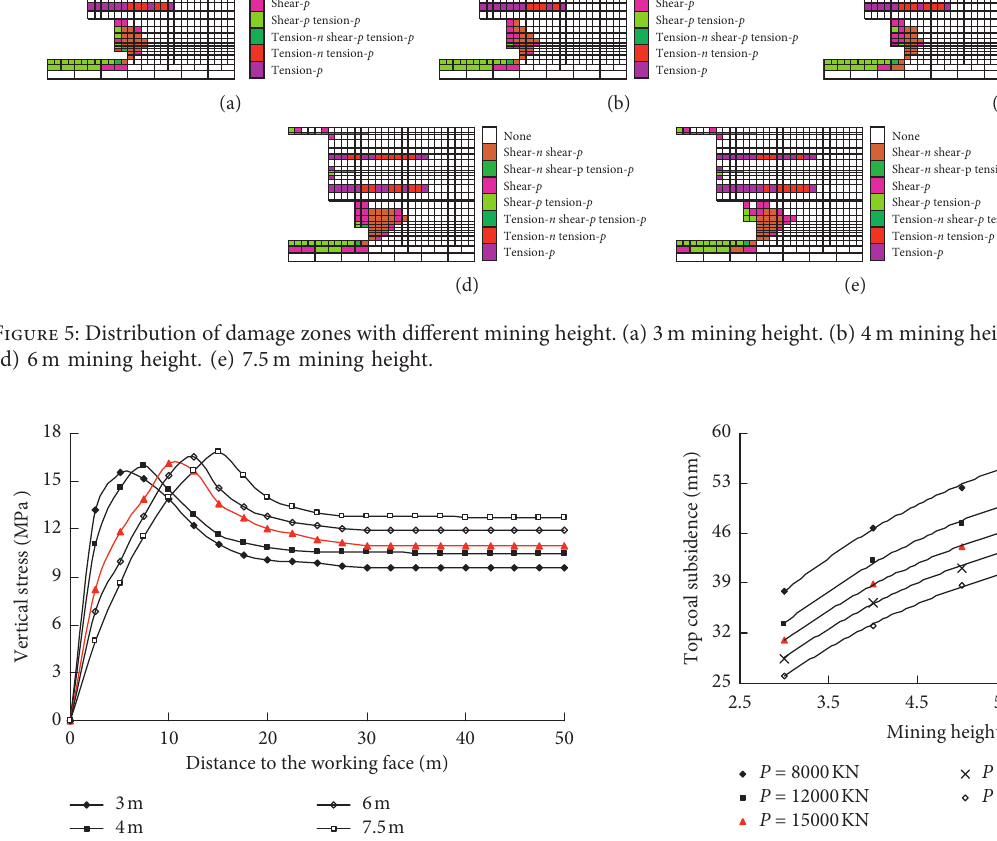
Figure 8: Variation curves of subsidence quantity with different mining